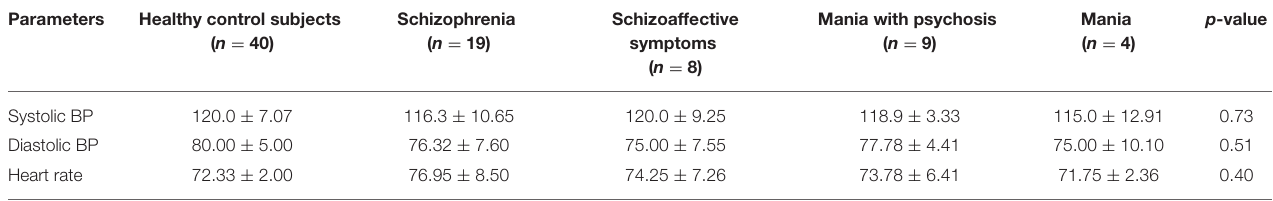
TABLE 4 | Evaluation of healthy control subjects vs. test group, i.e., patients with cannabis use and psychotic symptoms (schizophrenia, schizoaffective symptoms, mania with psychosis, and mania) for selected cardiovascular parameters (systolic BP, diastolic BP, and HR).